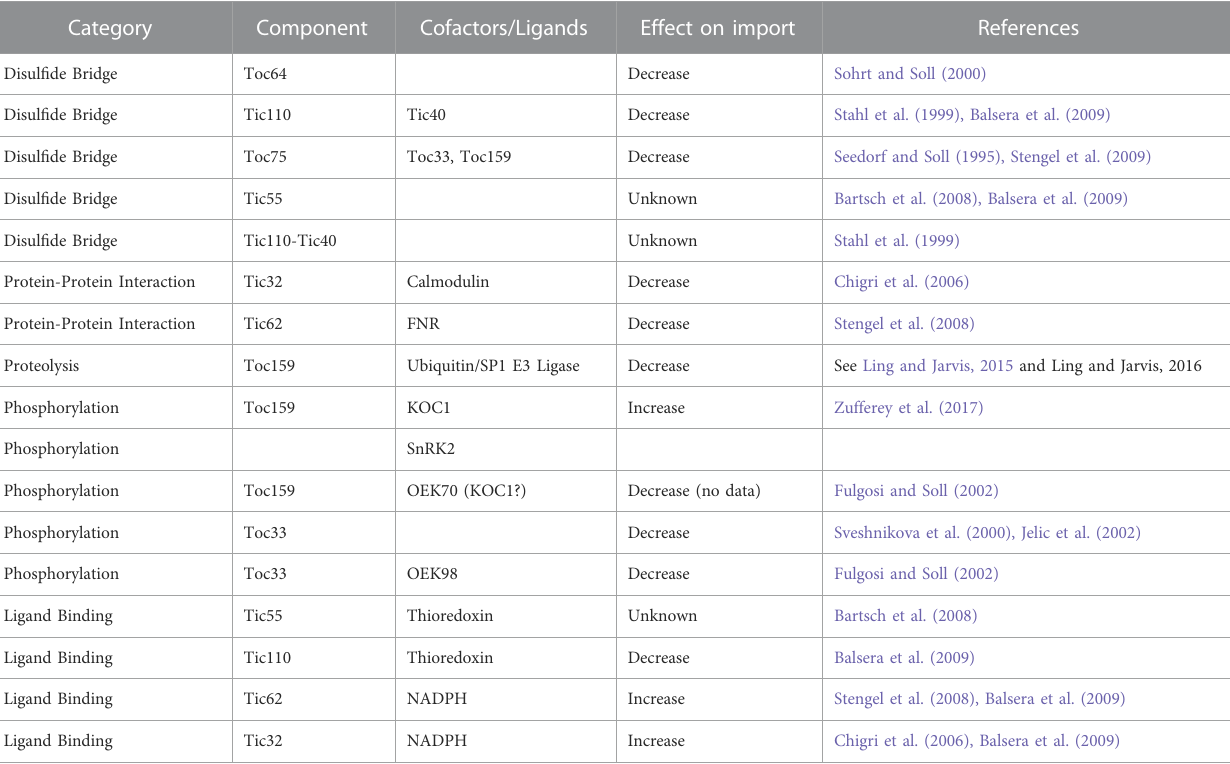
TABLE 1 Regulation Points of TOC/TIC. All current literature on regulation of protein import by formation of disul fi de bridges, protein-protein interactions, proteolysis, phosphorylation, and ligand binding are summarized. Where known, the effect of each component on import is indicated. Category Component Cofactors/Ligands Effect on